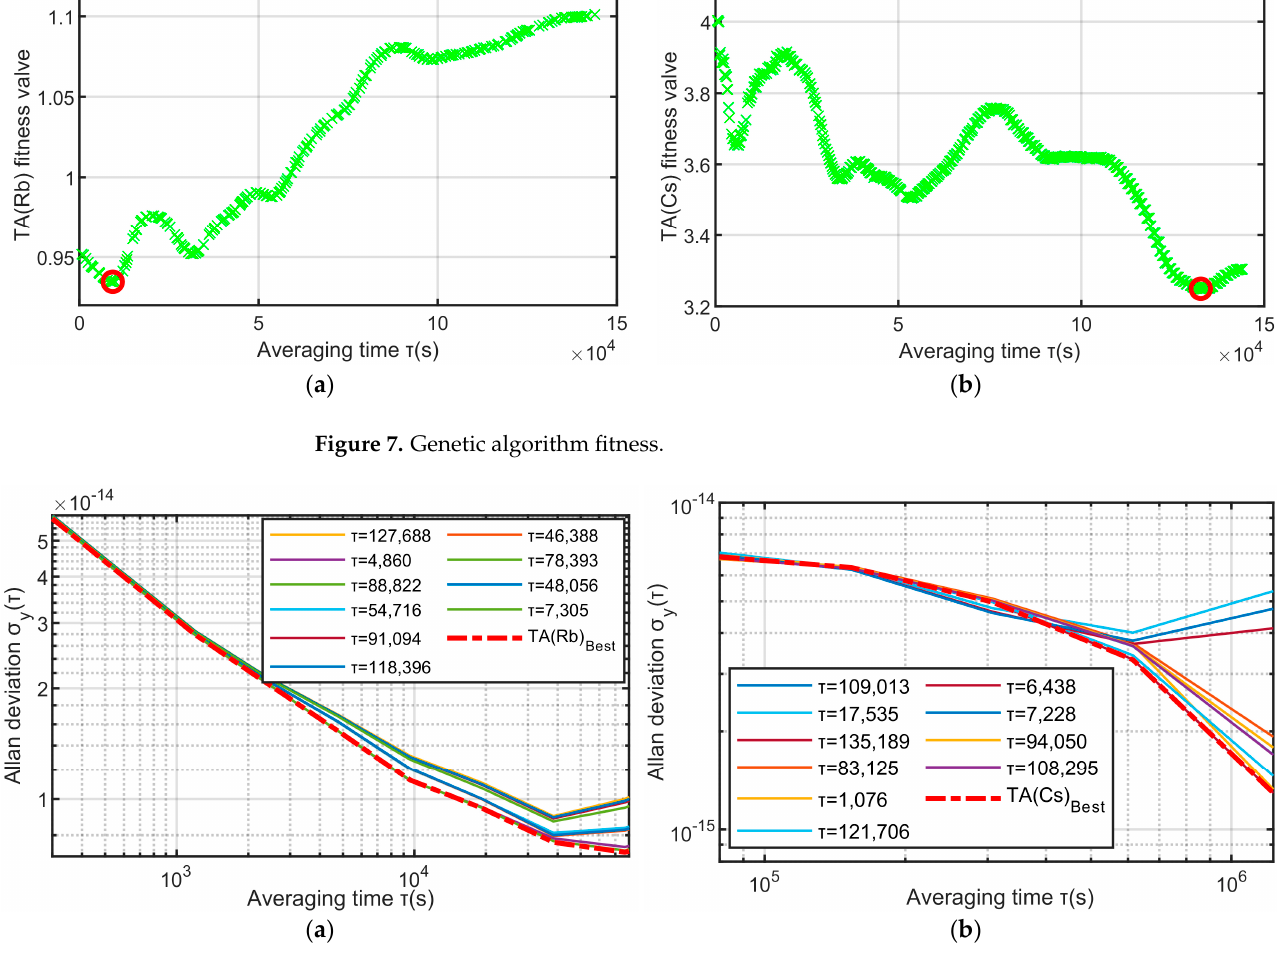
Figure 8. The frequency stability of the time scale of the fitness-optimal